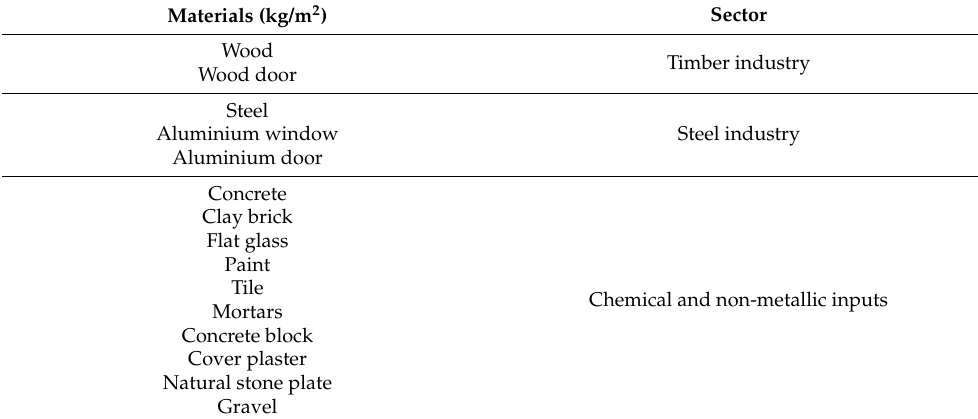
Table 3. Materials and